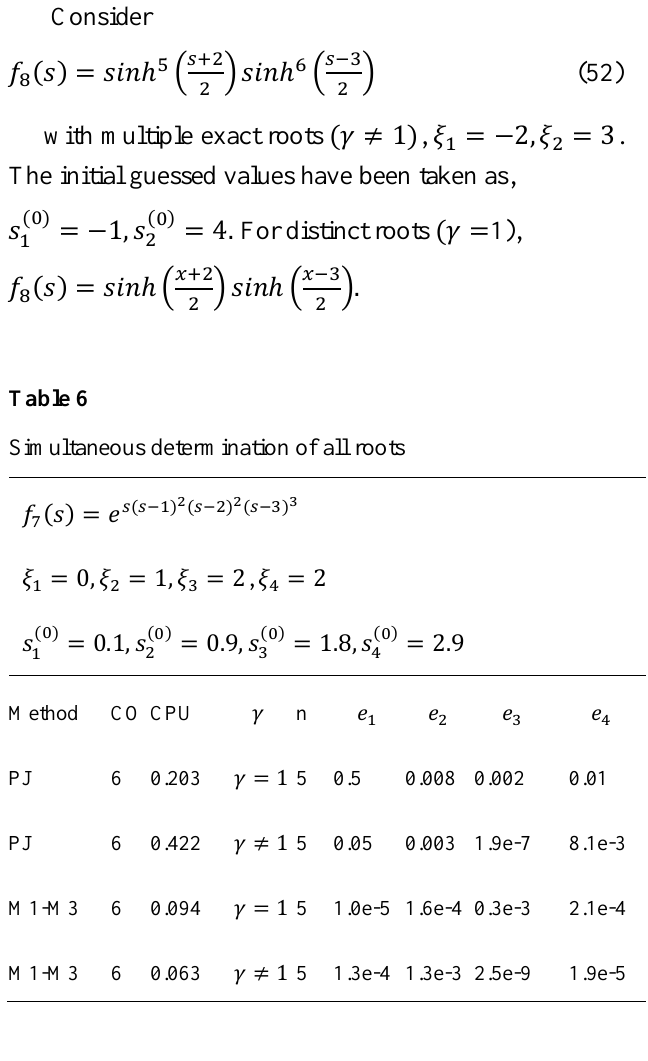
Comparison of single roots finding methods